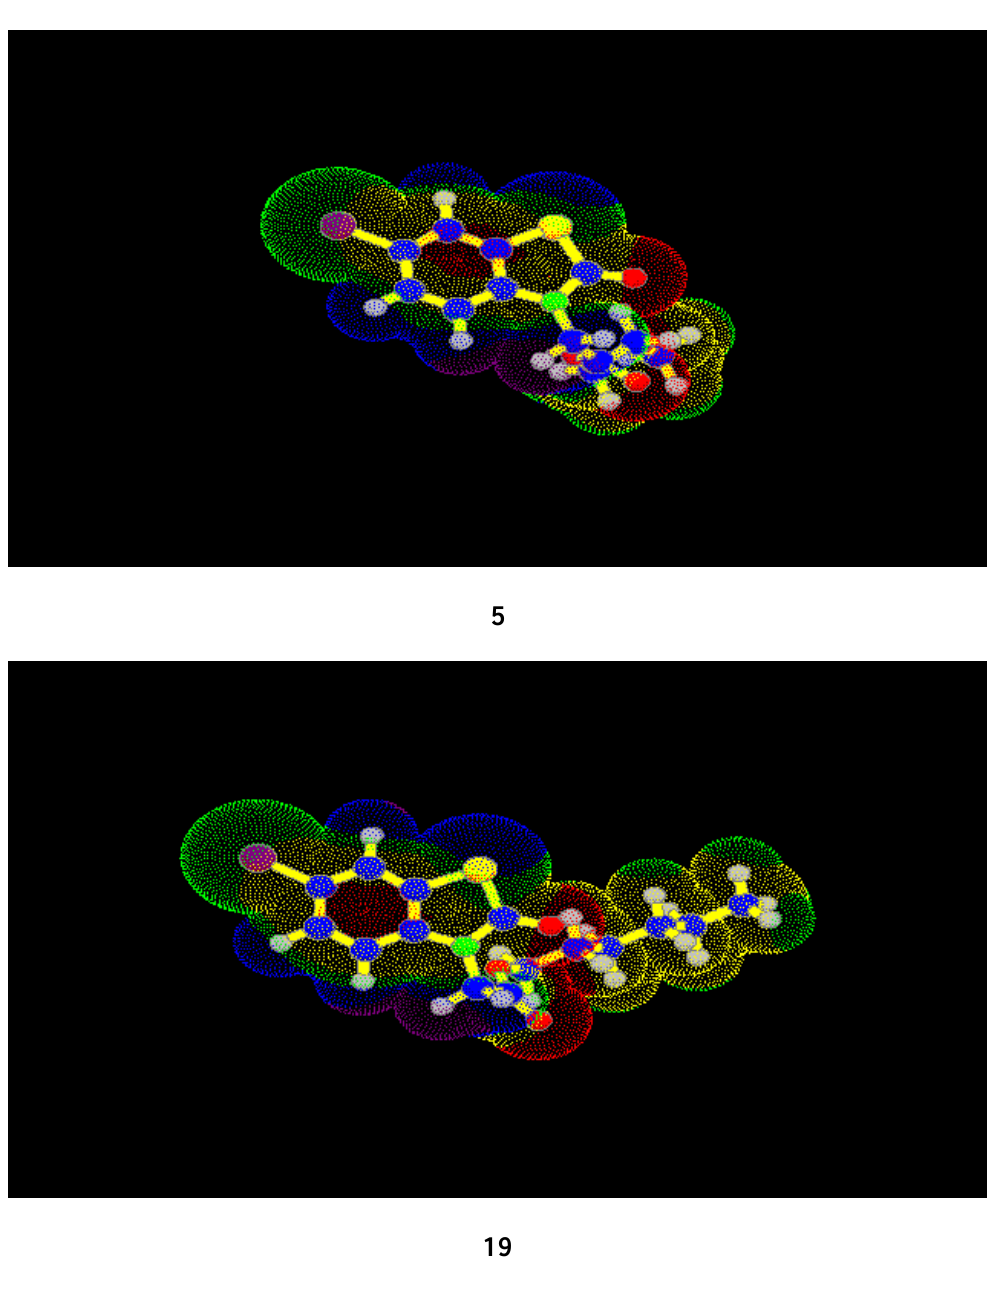
Figure 2. Structure and MEP on the van der Waals surface of 6-bromo ( 5 and 19 )